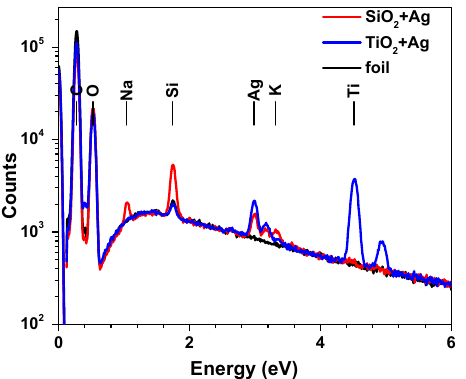
Figure 2. EDS spectra and element distribution of the polymer foils and the foils deposited with TiO 2 + Ag films, SiO 2 + Ag; all films have a total thickness of ~33 nm.